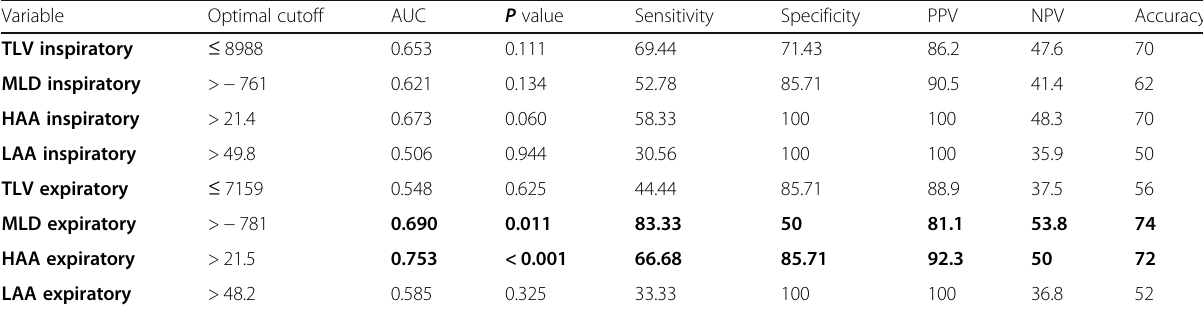
Table 5 Receiver operating characteristic (ROC) curve analysis for the prediction of severe interstitial lung disease